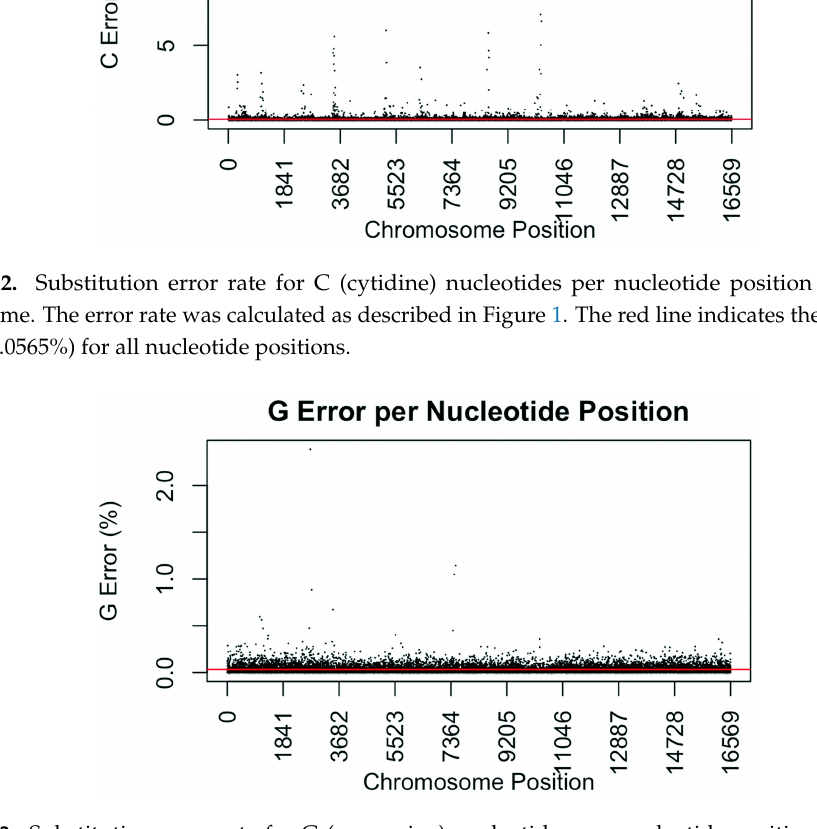
Figure 4. Substitution error rate for T (thymidine) nucleotides per nucleotide position across the mtgenome. The error rate was calculated as described in Figure 1. The red line indicates the average T error (0.0304%) for all nucleotide positions. Our evaluation of error for each nucleotide indicates that the assumed rate of error varies across the mtgenome and supports previous studies [50]. The highest rates of error for each nucleotide (25 rates for A, G, and T, and 35 for C; to include all C rates >2%; 110 rates total) encompassed 105 positions with 99 of those positions falling within the coding region and nine positions within the CR. The estimated T error did not surpass 1.05% at any position in the mtgenome, while G error surpassed 2% at one position (np 2734), A error surpassed 2% at seven positions, and C error had the greatest number of sites, 31 nucleotide positions, surpassing 2% (Table 4). Even though 39 nucleotide